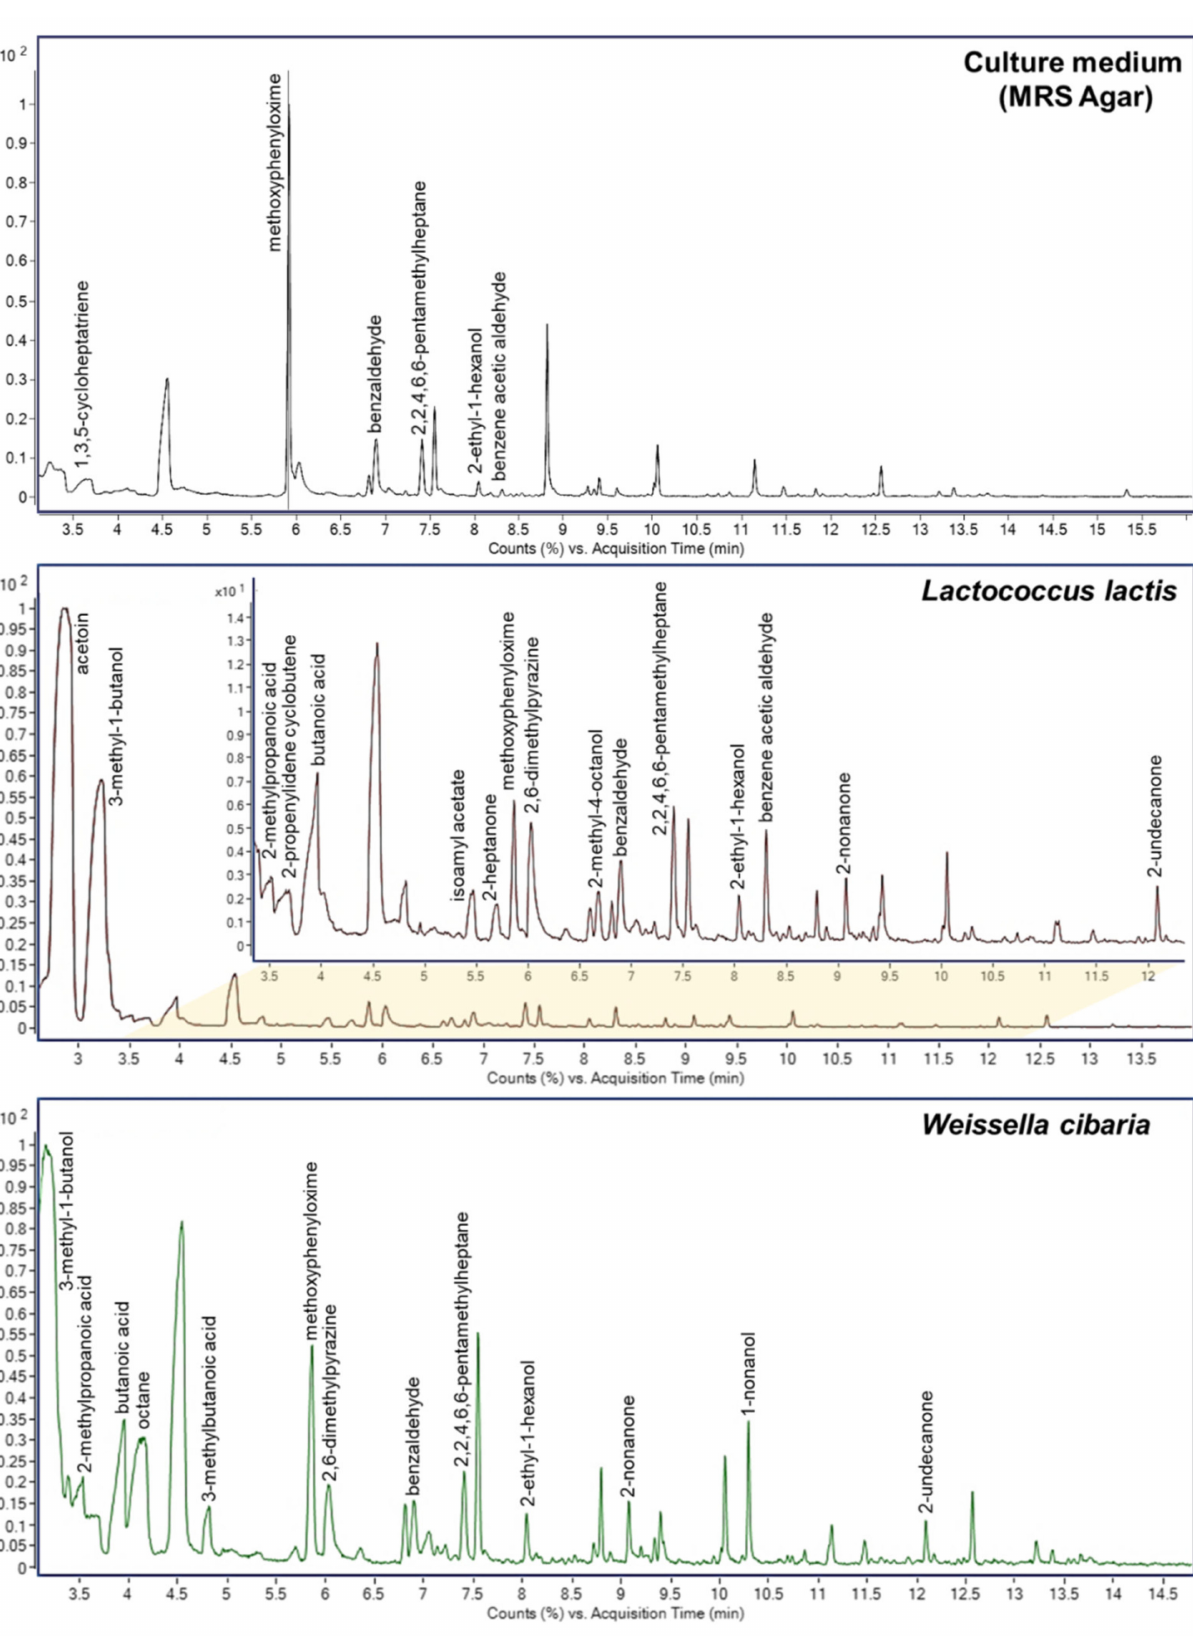
Figure 4. GC/MS chromatograms of control sample (MRS agar) and analyzed LAB strain